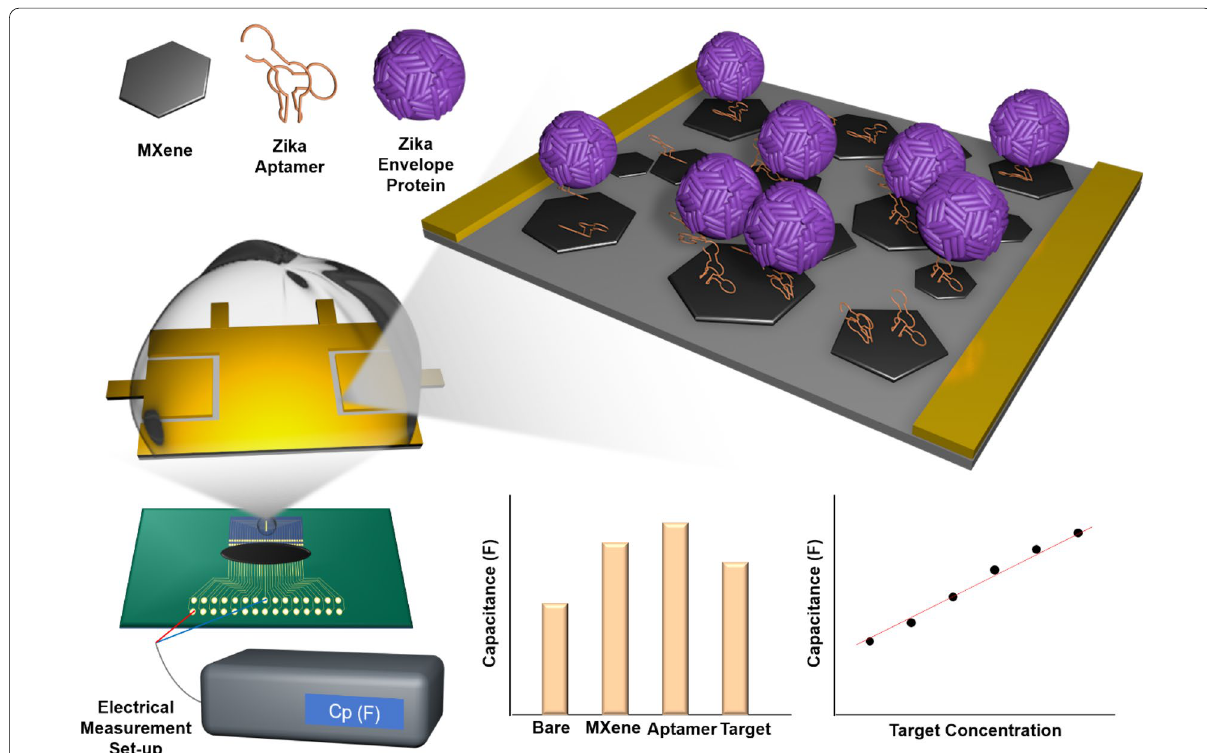
Fig. 1 Schematic image of the fabricated biosensor using the aptamer/MXene for zika virus detection